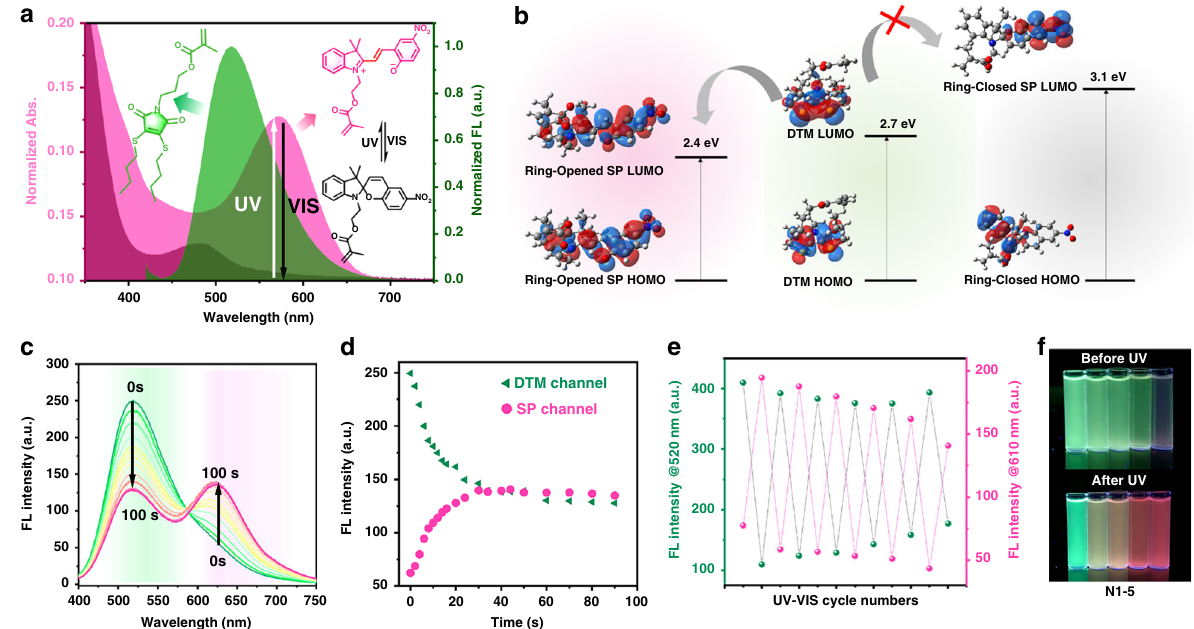
Fig. 2 Energy transfer involved photophysical behavior of nanogels. a Spectra overlap between the emission of the DTMMA (donor) and absorption of the SPMA (open and closed form, acceptor); b Schematic illustration of HOMO and LUMO isosurfaces of DTMMA and SPMA with their fi rst singlet excitation energies in a non-polar environment based on DFT and TD-DFT calculations; c , d Emission intensity changes of nanogel N4 before and after UV irradiation for 0 – 100 s ( λ ex. = 410 nm, slit width: Ex. = 1 nm, Em. = 1 nm); e Fluorescence intensity cycling upon UV and vis irradiation (the DTM channel was recorded at 520 nm and the SP channel was recorded at 610 nm, irradiation time: 120 s); f Fluorescence images of the light-switchable nanogel solutions (N1 – 5) before and after UV irradiation for 120 s. Related data are provided in Source data fi